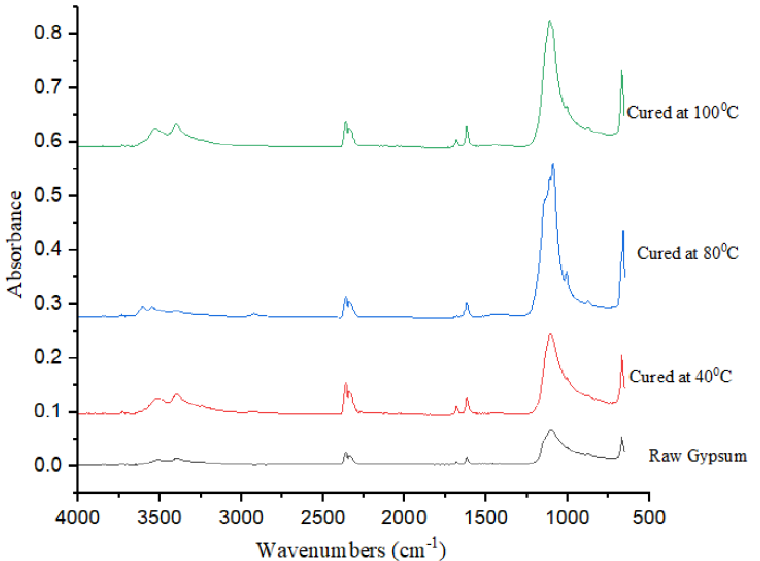
Figure 14. FTIR spectra of WFGD gypsum bricks and elevated temperatures.